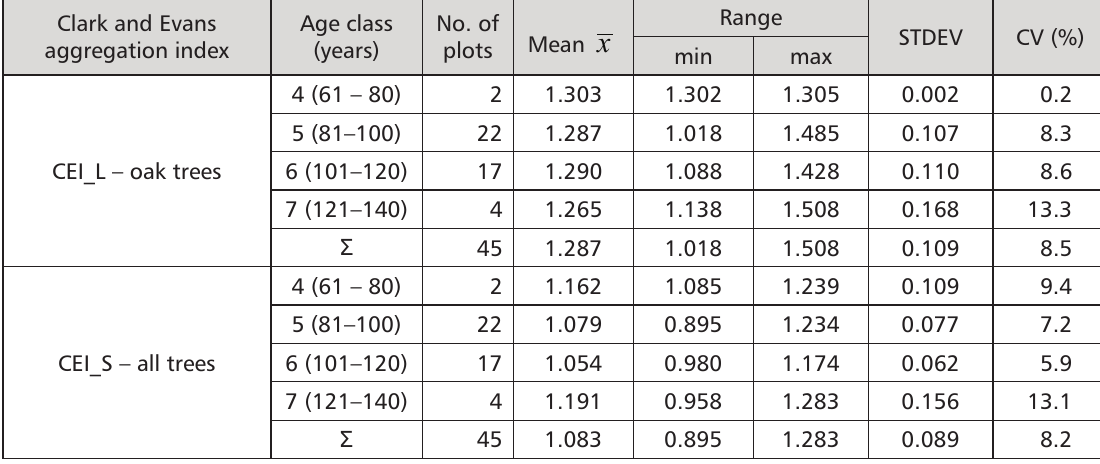
The aggregation index of Clark and Evans by 20-year age